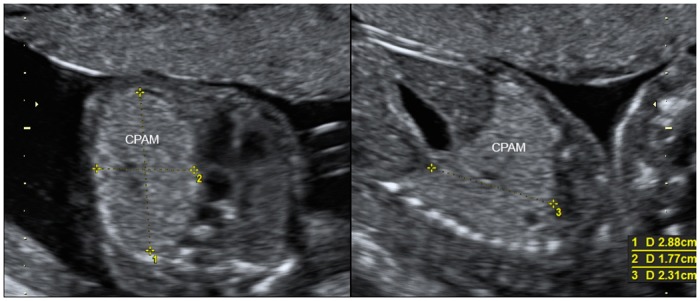
Transverse and longitudinal section of the fetal thorax demonstrating a large microcystic congenital pulmonary airway malformation (CPAM) with mediastinal shift at 19 weeks of gestation.CVR (CPAM volume ratio): 2.88 x 1.77 x 2.31 x 0.52/16.1 (head circumference) = 0.38.